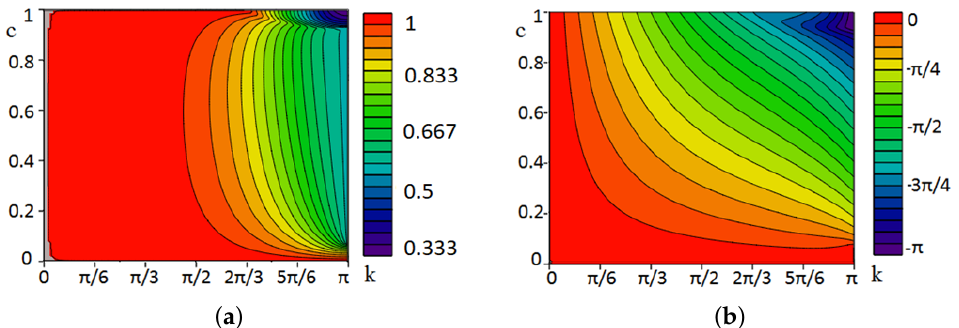
Figure 3. The values of the module ( a ) and the argument ( b ) of the root of the characteristic equation for the scheme